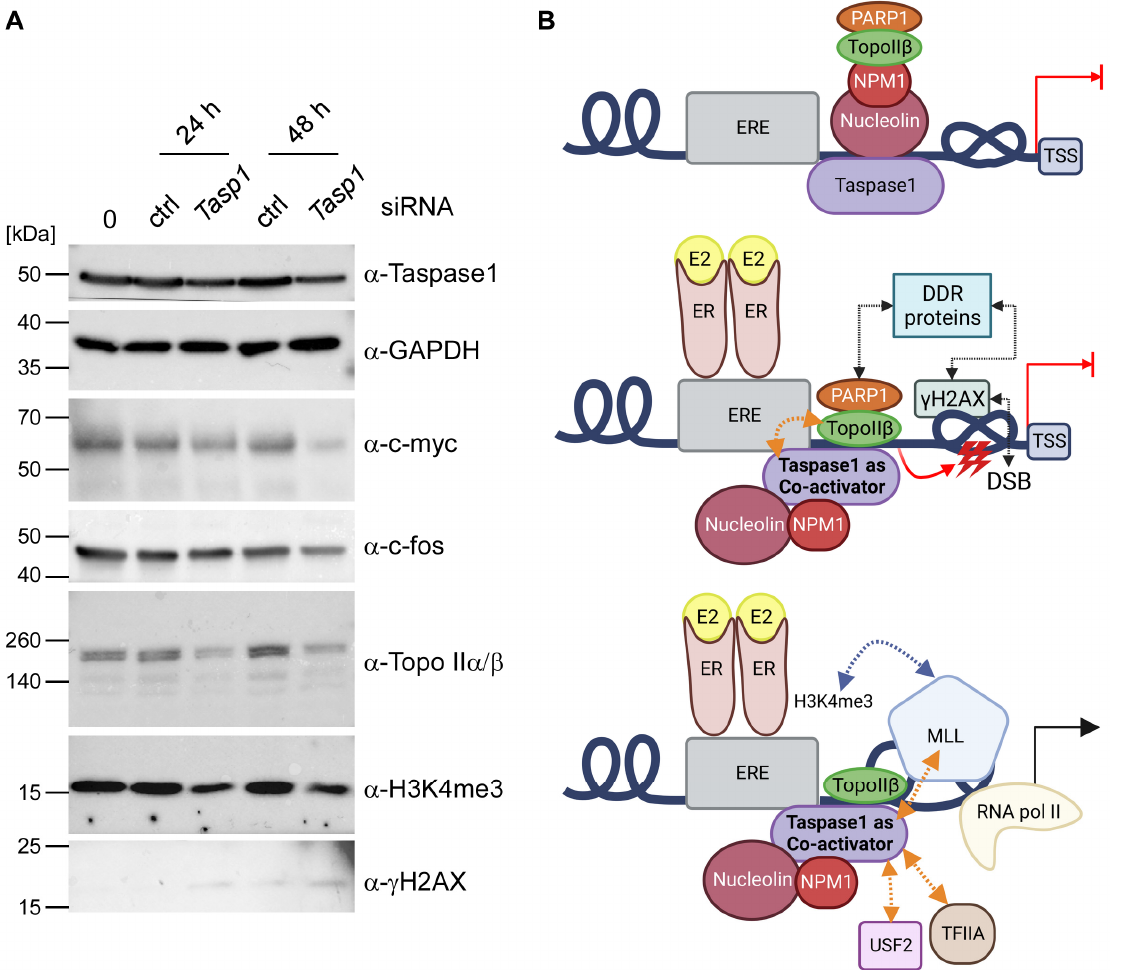
Figure 5. Taspase1 is a co-activator of estrogen-driven transcription. ( A ) Downregulation of Taspase1 affects the transcriptional estrogen response. Western Blot analysis of whole cell lysates of untransfected 293T cells or 293T cells 24 h and 48 h after transfection with Taspase1 siRNA or control siRNA unravels a partial Taspase1 knock-out coupled with an attenuated expression of estrogene- responsive genes. ( B ) Model of Taspase1-influenced estrogen-driven transcription: In an uninduced